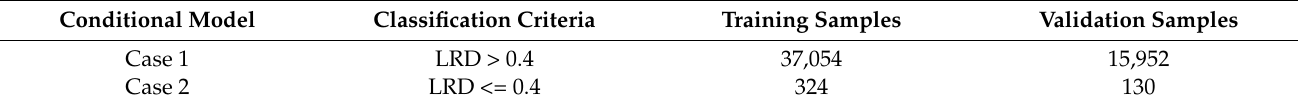
Table 3. Details of the two conditional models for R n